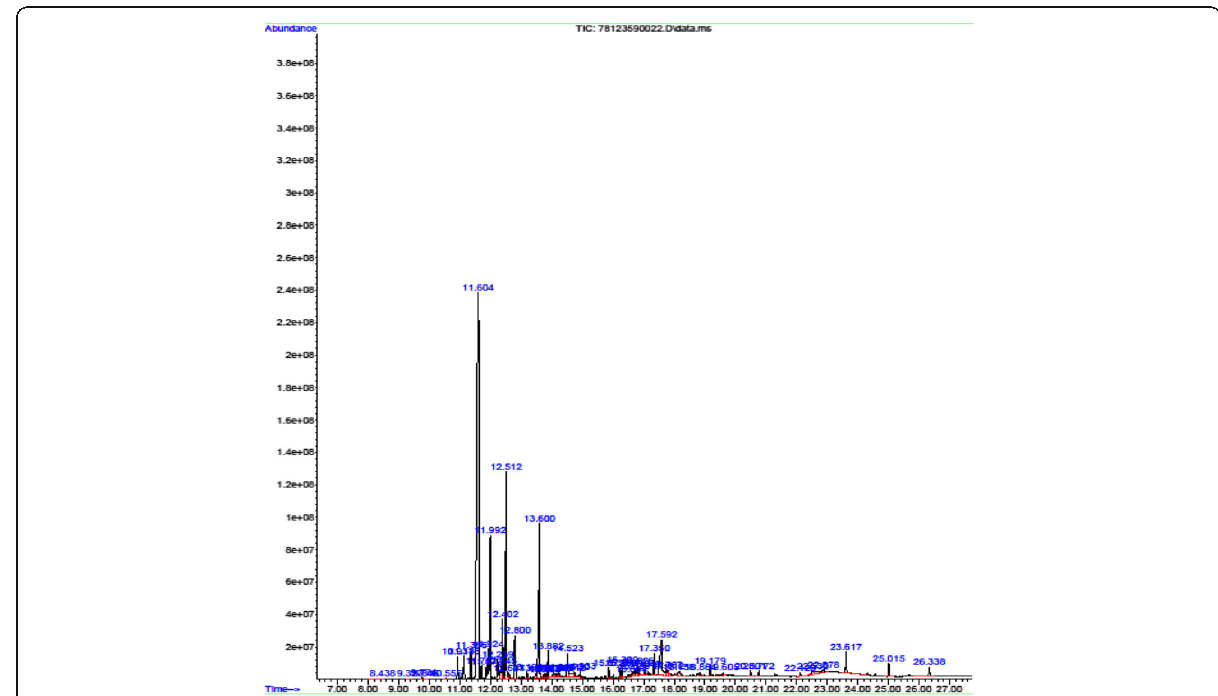
Fig. 2 GC-MS analysis of oil leaf extract of L .